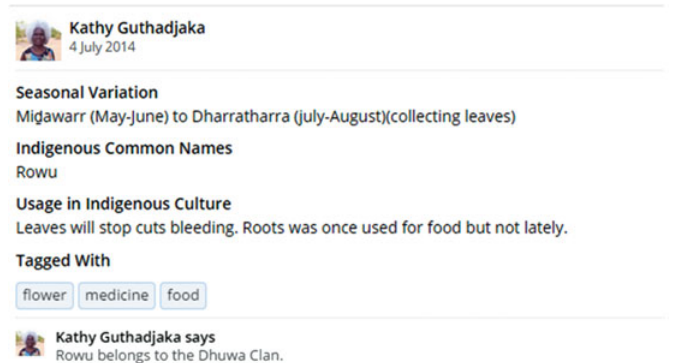
(Colour online) A sample of the information shared by Guthadjaka in the available